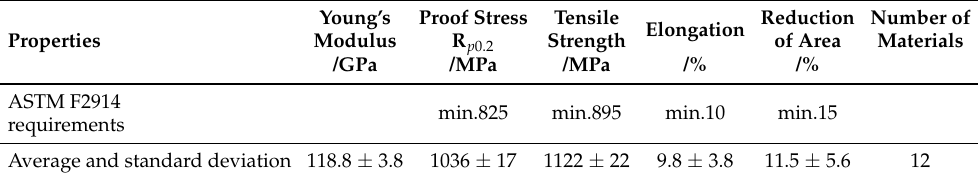
Table 2. Tensile properties of as-built material [27].